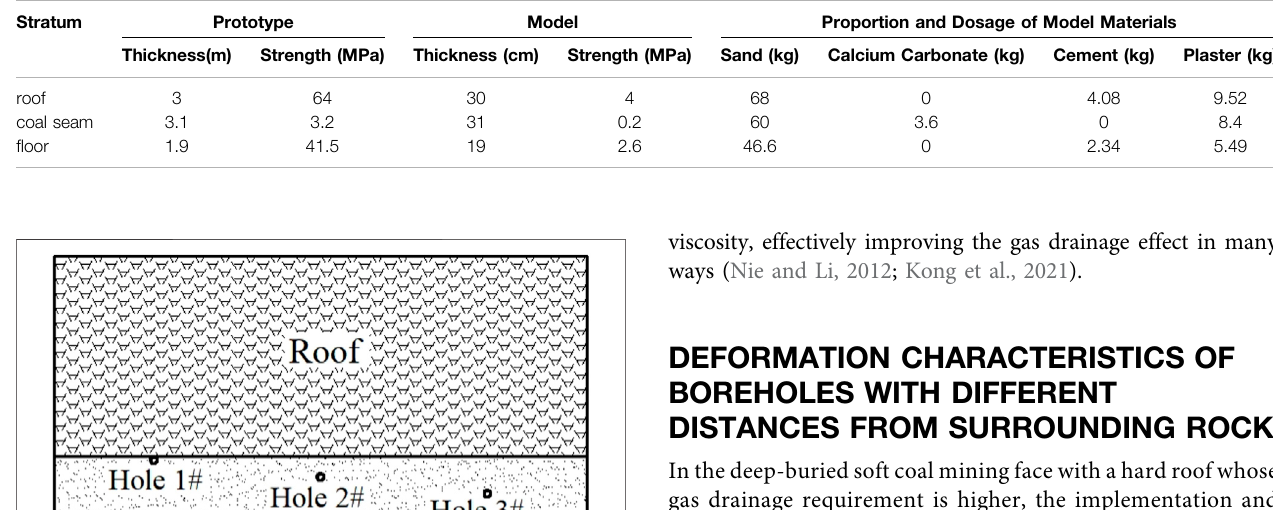
TABLE 1 | Physical model proportioning parameters.